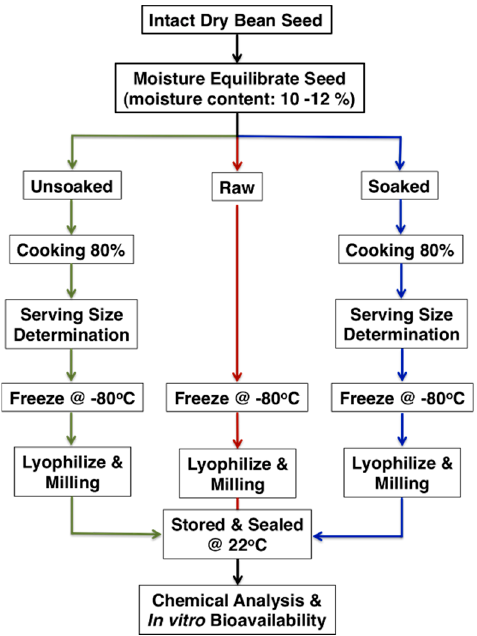
Figure 2. Flow diagram illustrating how cooking time is measured for bean seeds and how raw/cooked seed are processed for nutritional analysis and bioavailability assays.